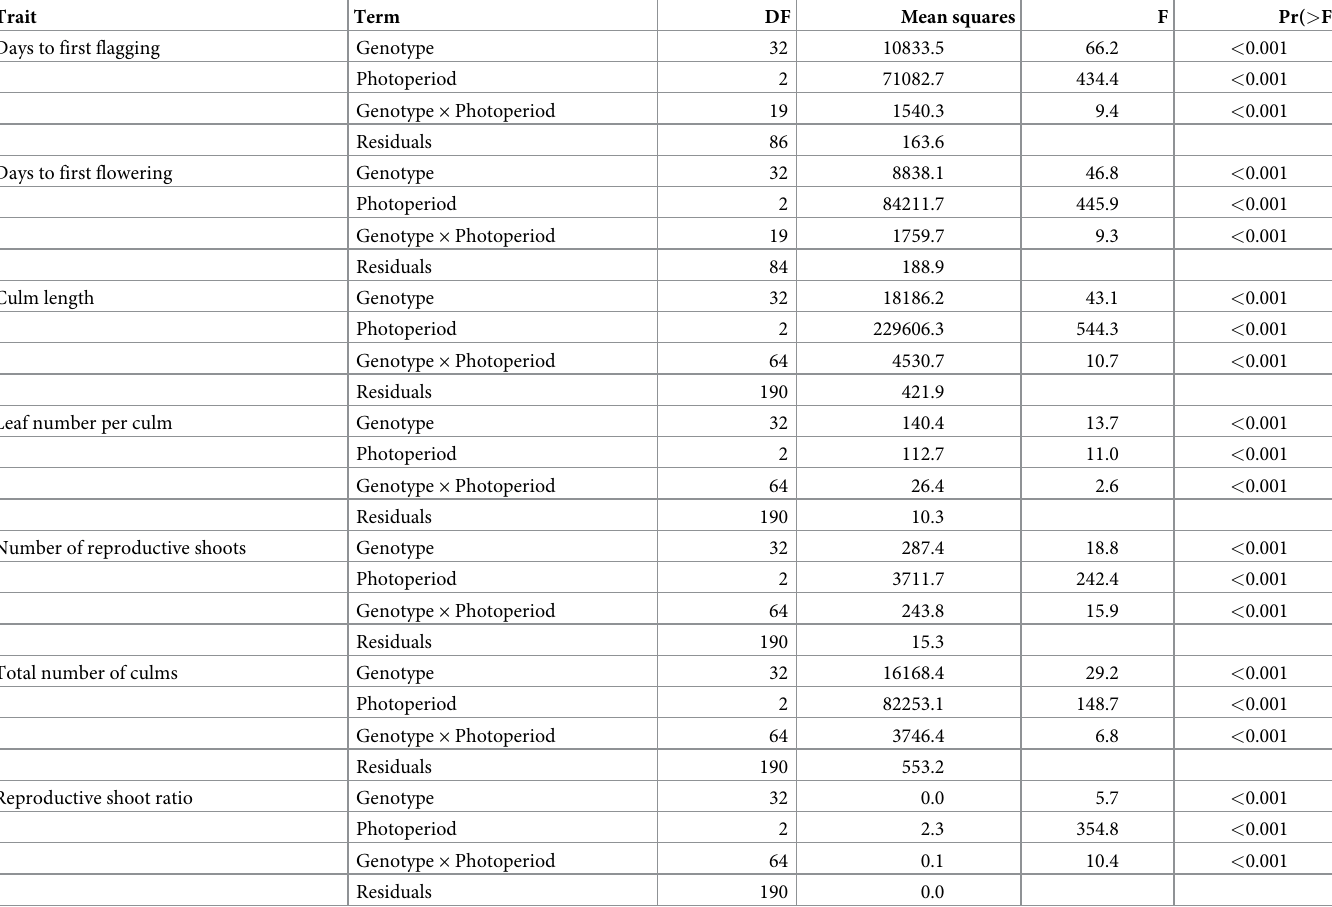
Table 6. Effects of genotype, photoperiod, and their interactions on nine flowering and morphological traits of Miscanthus .